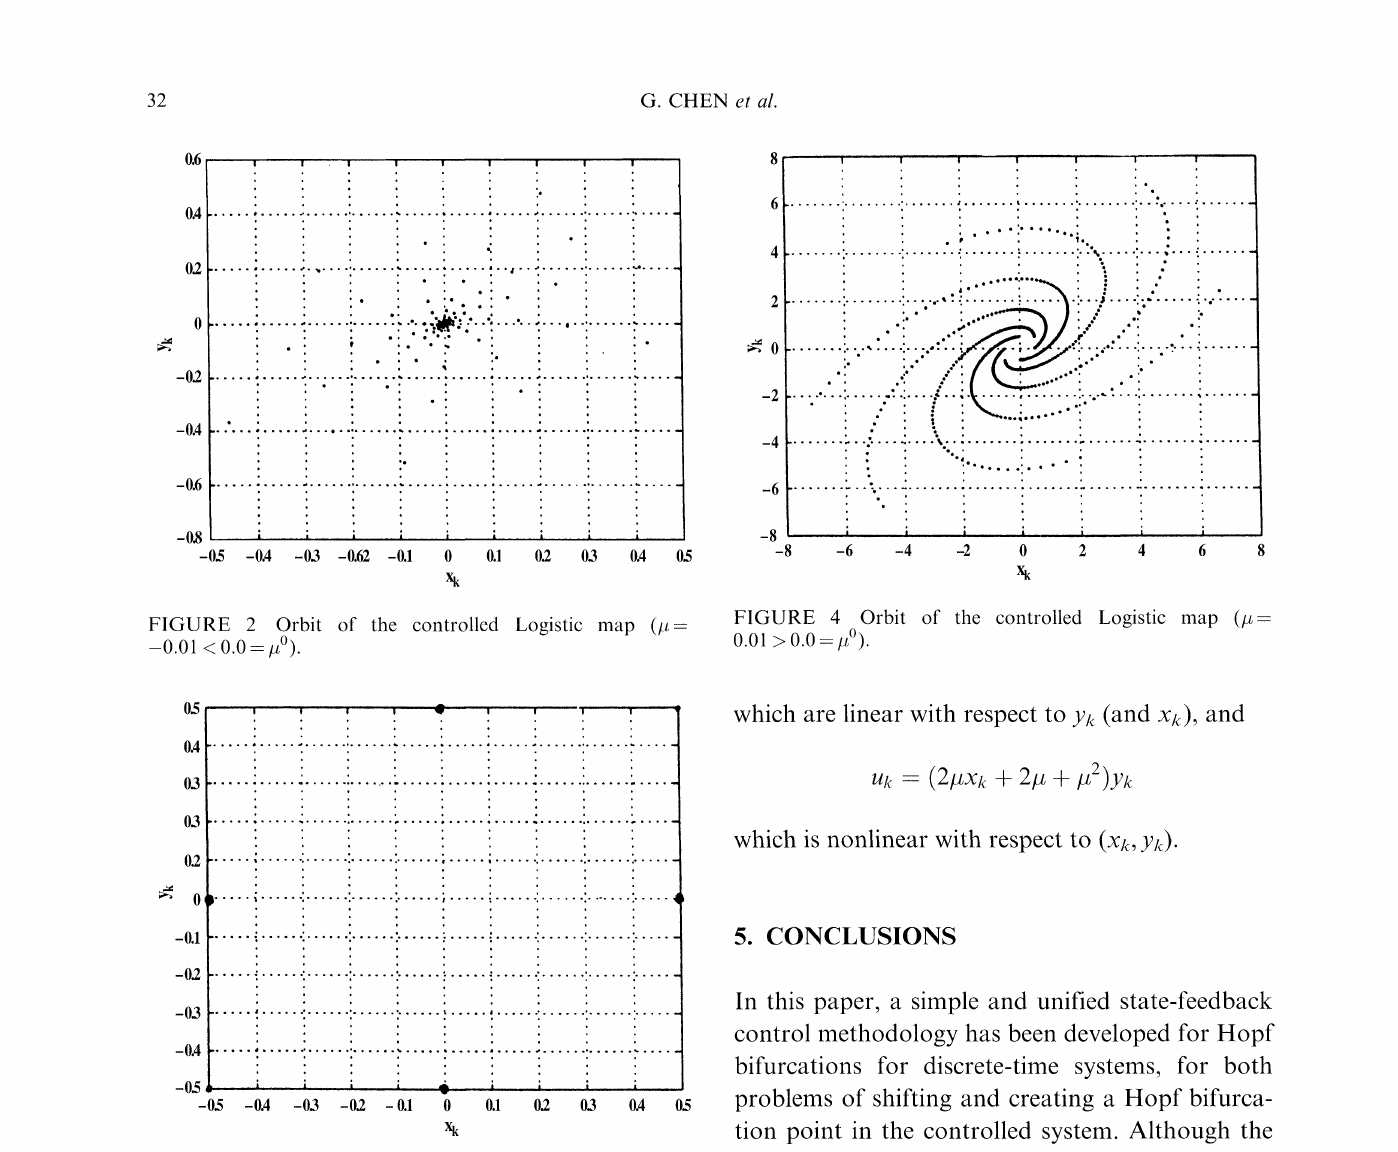
FIGURE 3 Orbit of the controlled Logistic map (#= 0.0-